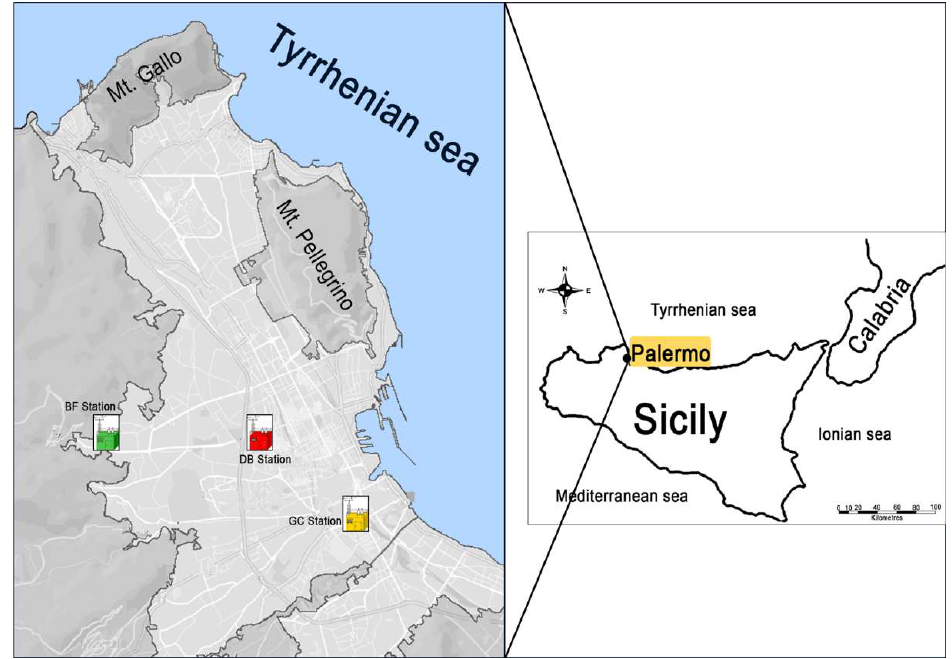
Figure 1. Location of study area with sampling sites. BF, Boccadifalco; DB, Di Blasi; GC, Giulio Cesare. Int. J. Environ. Res. Public Health 2019 , 16 , x